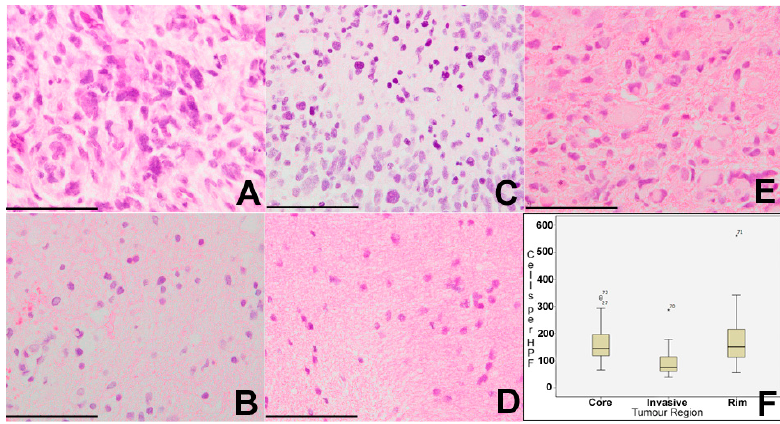
Figure 1. Intra-tumour cellular density reveals spatial heterogeneity. Cell density in all samples was assessed on H&E sections with a median of 127 cells per high-powered field (HPF) across all of the tumour regions (range 39–561 cells per HPF). ( A , B ) Tumour core. ( C ) Tumour rim. ( D , E ) Tumour invasive margin. ( F ) Core samples had a median cell density of 144 cells per HPF (range 66–335), rim samples a median of 152 cells per HPF (56–561) and invasive samples median of 76 cells per HPF (39–287). On pairwise post-hoc t -test, there were significant differences between core and invasive regions (* p = 0.018) and between rim and invasive regions (* p = 0.045) but not between core and rim regions ( p = 0.849). ( A – E ) × 200. Error bars ( A – E ) 25 µ